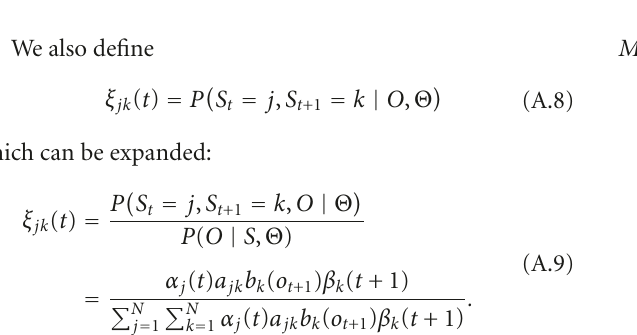
Figure 13: Neural Tuning depth with high random firing